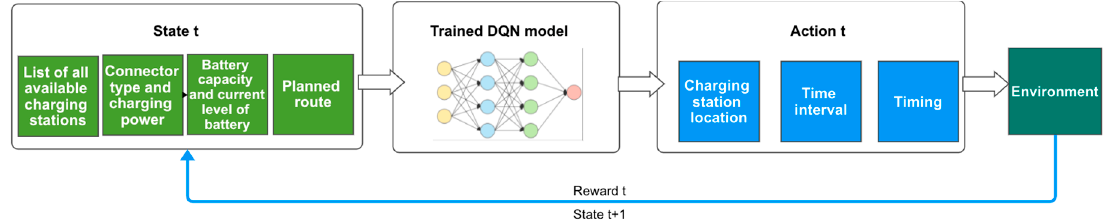
Figure 1. Study Methodology.